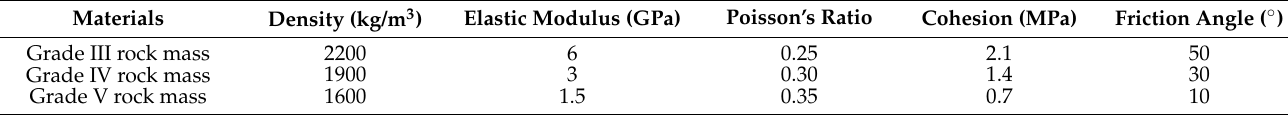
Table 3. Parameters of three types of the surrounding